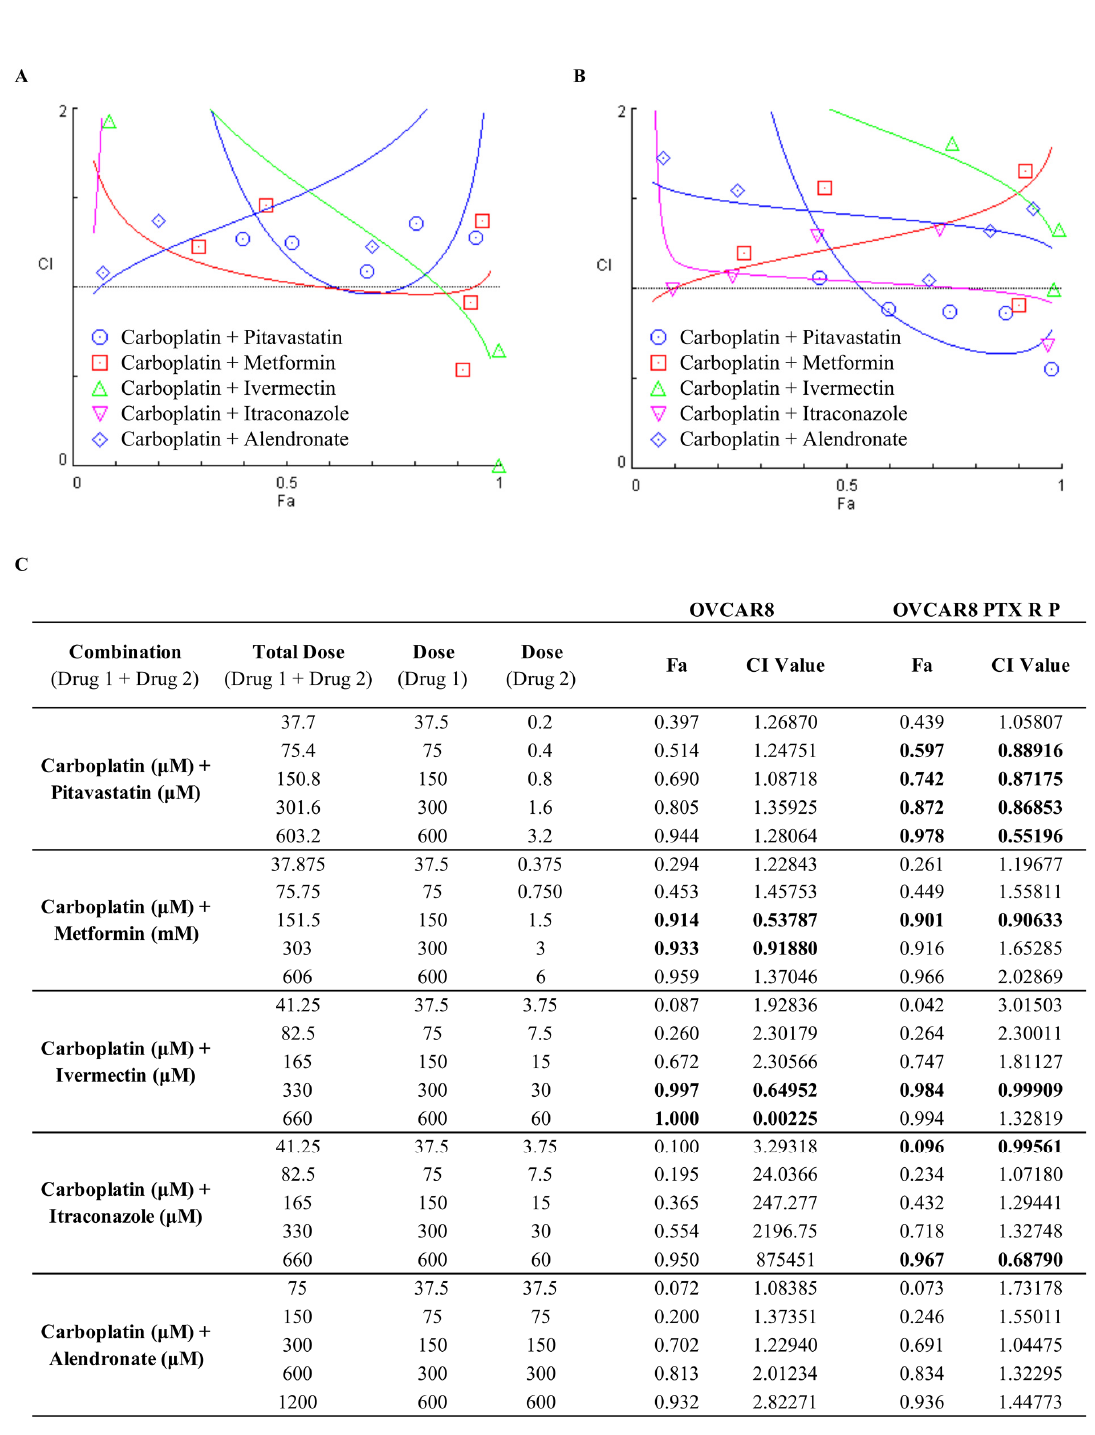
Figure 3. Combining Carboplatin with repurposed drugs has a synergistic effect on chemoresistant high-grade serous carcinoma cells. ( A , B ) Chou–Talalay method effect level (Fa)—Combinatory Index (CI) plot and ( C ) Fa values and respective combinatory index (CI) values showing drug synergism of ( A ) OVCAR8 and ( B ) OVCAR8 PTX R P cells, after exposure to fixed dose ratios that correspond to 0.25, 0.5, 1, 2 and 4 fold the individual IC 50 values each drug, e.g., Carboplatin combined with Pitavastatin, Metformin, Ivermectin, Itraconazole and Alendronate for 48 h. The combined treatment was co-administered at the same time. All assays were performed in triplicate in at least three independent experiments. CI was plotted on the y-axis as a function of Fa on the x-axis to evaluate drug synergism. CI: <1 (synergism, bold), =1 (additivity) and >1